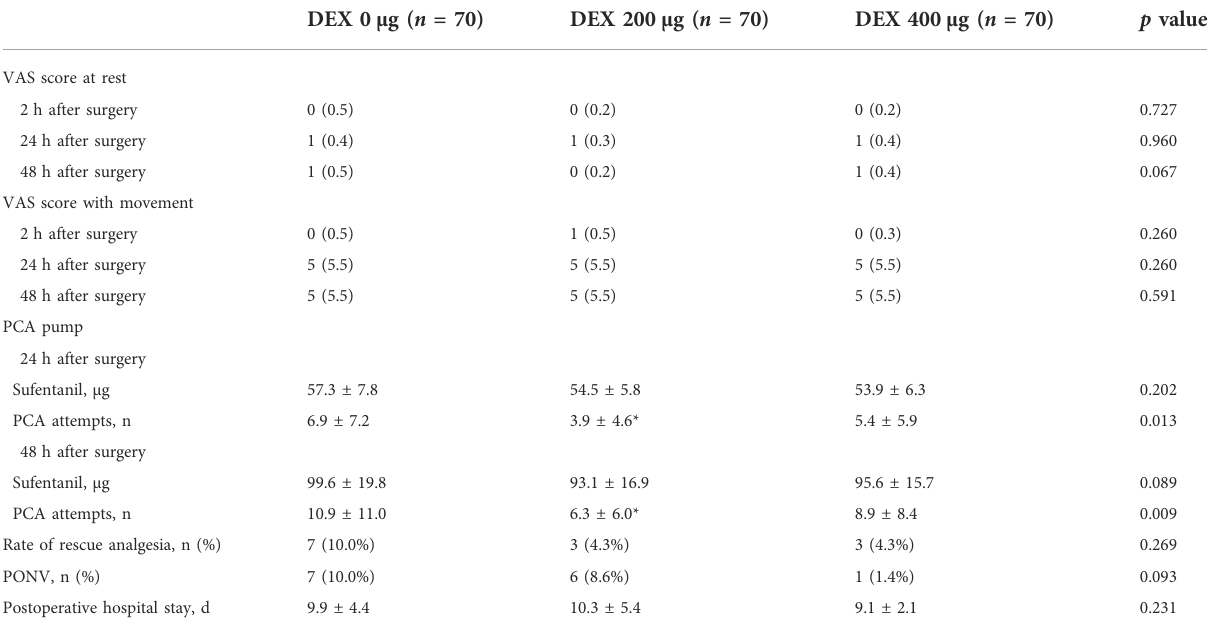
TABLE 3 Other outcomes of patients in the three